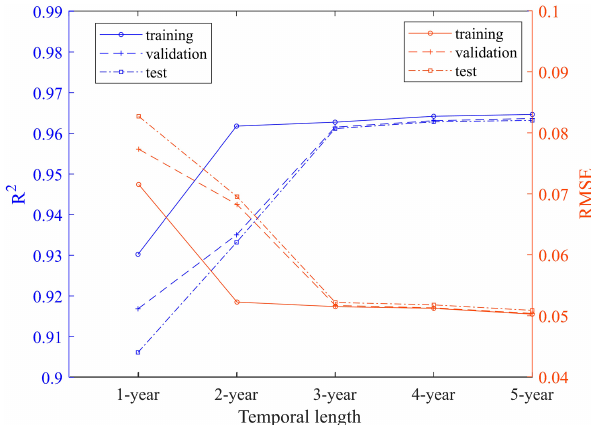
Figure 3. Evaluation of the temporal length of the Bi-LSTM